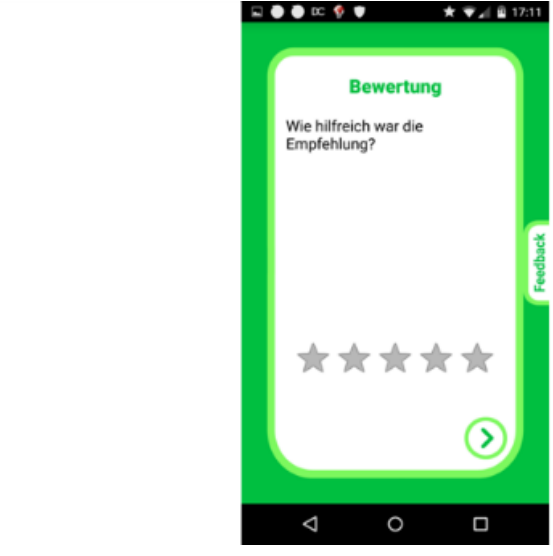
Figure 5. Sample screenshots of an intervention rating. The subject is asked for perceived usefulness of the intervention on a 5-star rating scale (in German